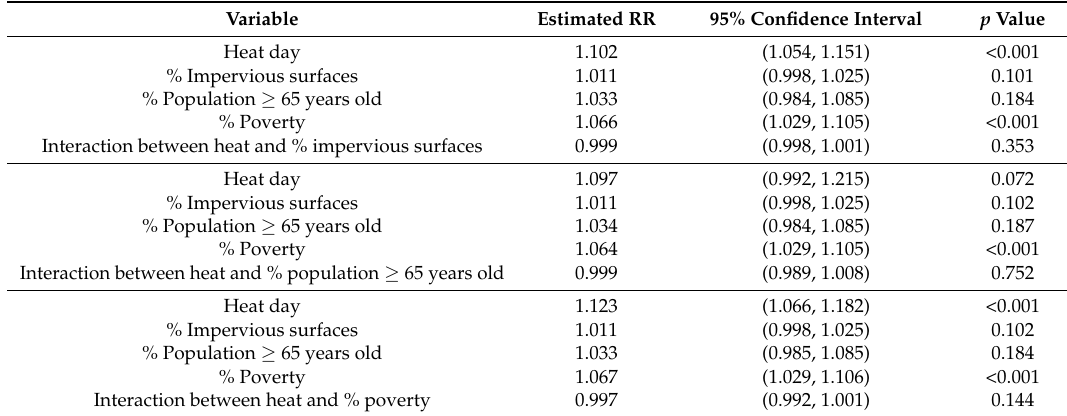
Table A1. Relative rate results: effect modifications of the environmental and demographic factors on the association between heat exposure and daily BLS call counts 1